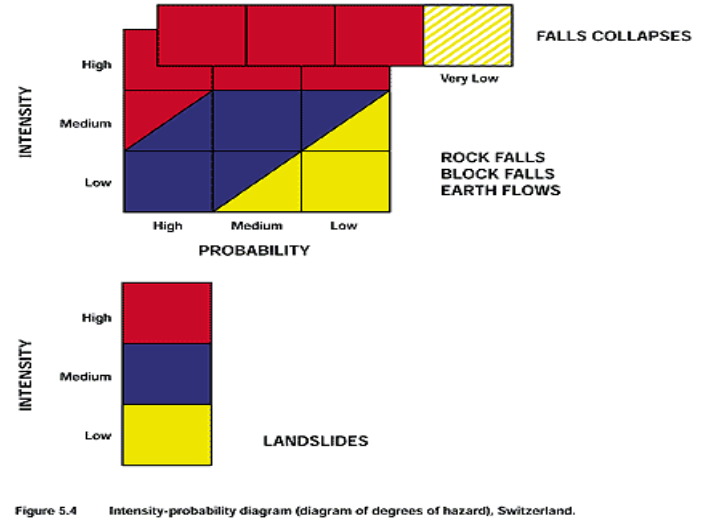
Figure 1. Diagram of degrees of hazard for some fall, slide and flow processes